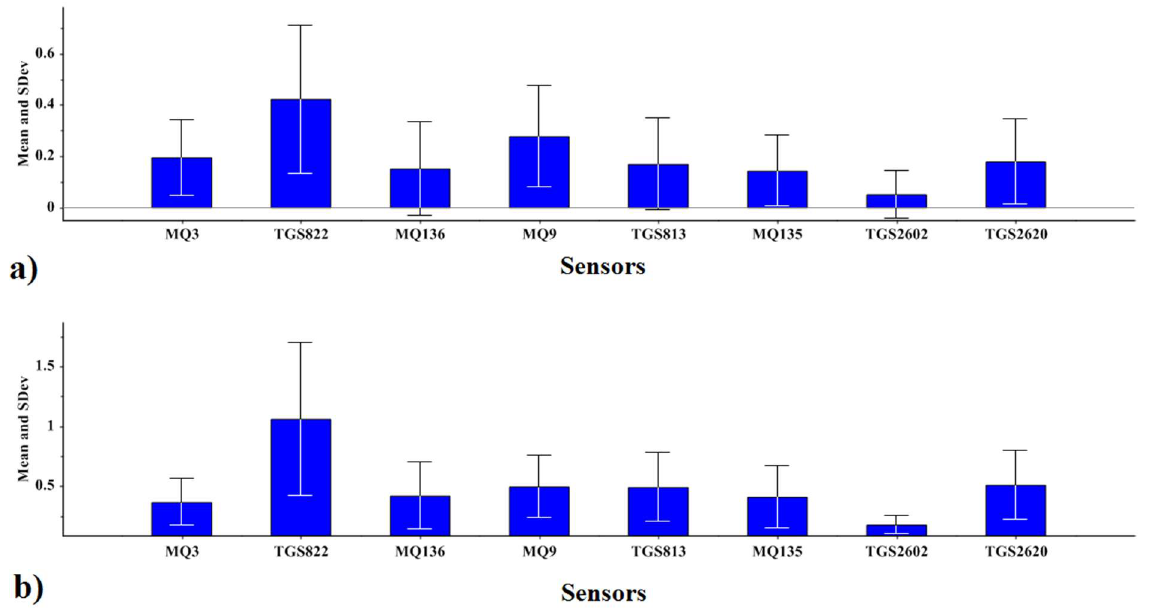
Figure 3. E-nose sensor array output responses to VOCs from DWE and EO sample extractions. Bar graph of individual sensor outputs (±1 SD) for: ( a ) Water DWE extract (second fraction), and ( b ) Oil steam-distillate EO (first fraction) between treatment means using Duncan’s multiple range test.